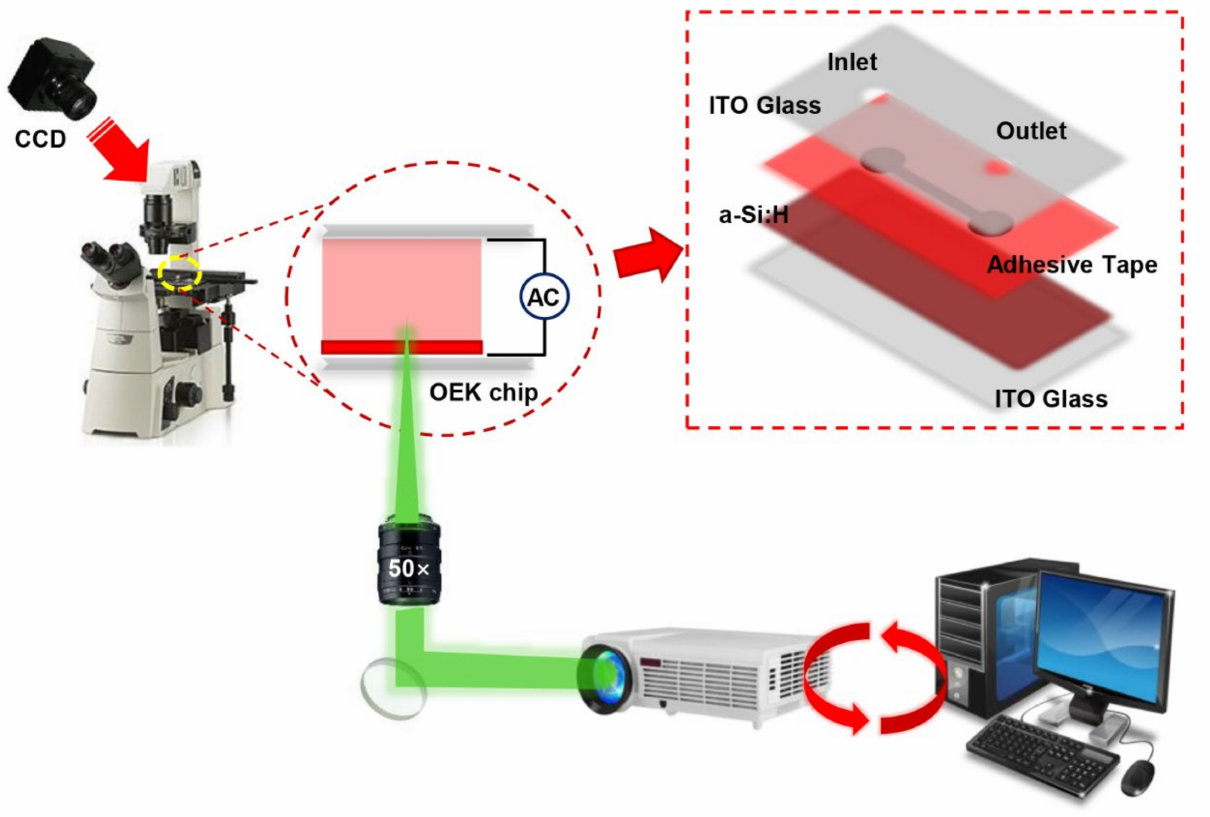
Figure 1. Schematic illustration of the ODEP-based microfluidic platform used as the experimental setup. The inset is an exploded view of the ODEP